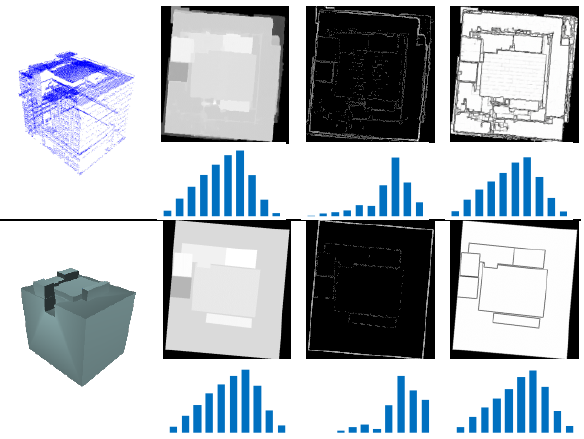
Figure 6. Consistent encoding of point clouds and